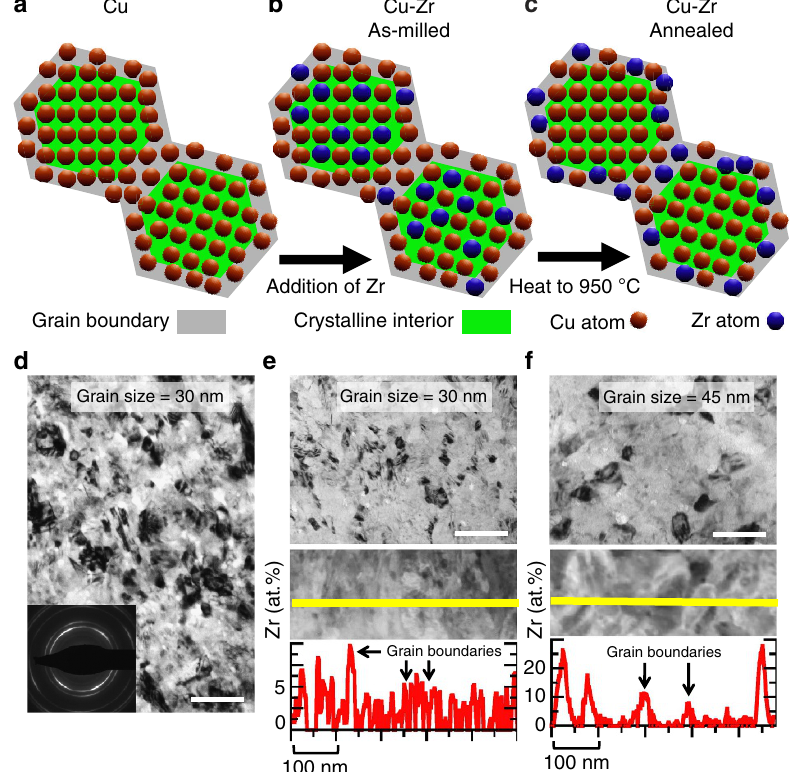
Figure 1 | Alloy design strategy for adding segregating dopants. Pure Cu ( a ) can be converted to an alloy by adding Zr during ball milling ( b ). Although the Zr is mixed throughout the grain structure, annealing treatments can then be used to induce preferential Zr segregation to the grain boundaries ( c ). Both the ( d ) pure Cu and ( e ) Cu-Zr as-milled samples have an average grain size of 30nm (scale bars, 100nm). ( f ) Annealing the Cu-Zr sample at 950 (cid:2) C for 1h allows for segregation and only causes coarsening to a grain size of 45nm (scale bar, 100nm). The same level of Zr segregation was found in both the quenched and air-cooled